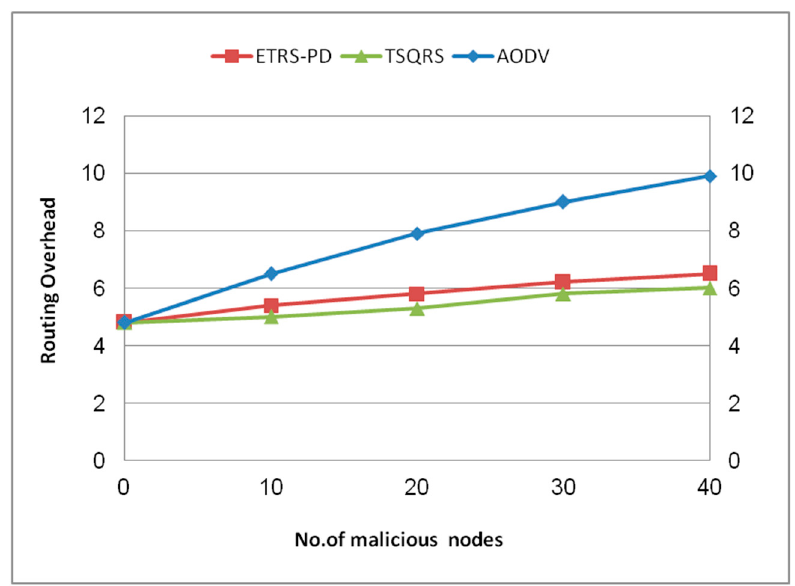
Figure 9. RO against percentage of malicious nodes.